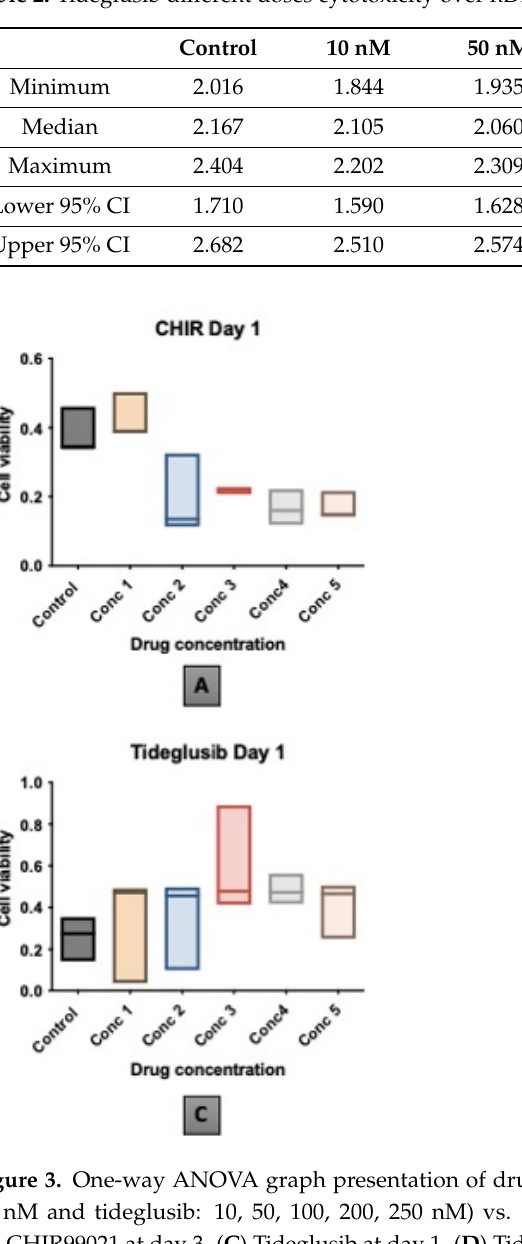
Table 2. Tideglusib different doses cytotoxicity over hDPSCs at day 3.